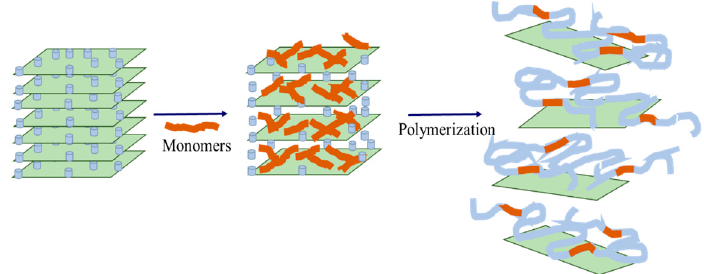
Figure 1. Schematic diagram of in situ intercalated polymerization.